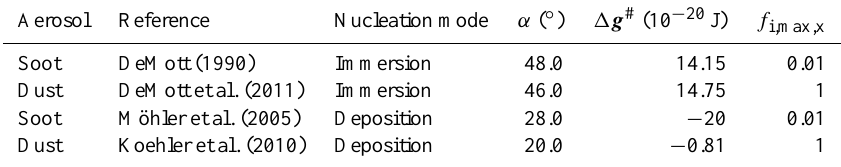
Table 1. Parameters for the ice nucleation parameterization in the single contact angle ( α ) model. In the table, DeMott et al. (2011) and Koehler et al. (2010) represent Saharan dust. 1 g # is the activation energy; f i,max,x is the maximum ice nucleating fraction.